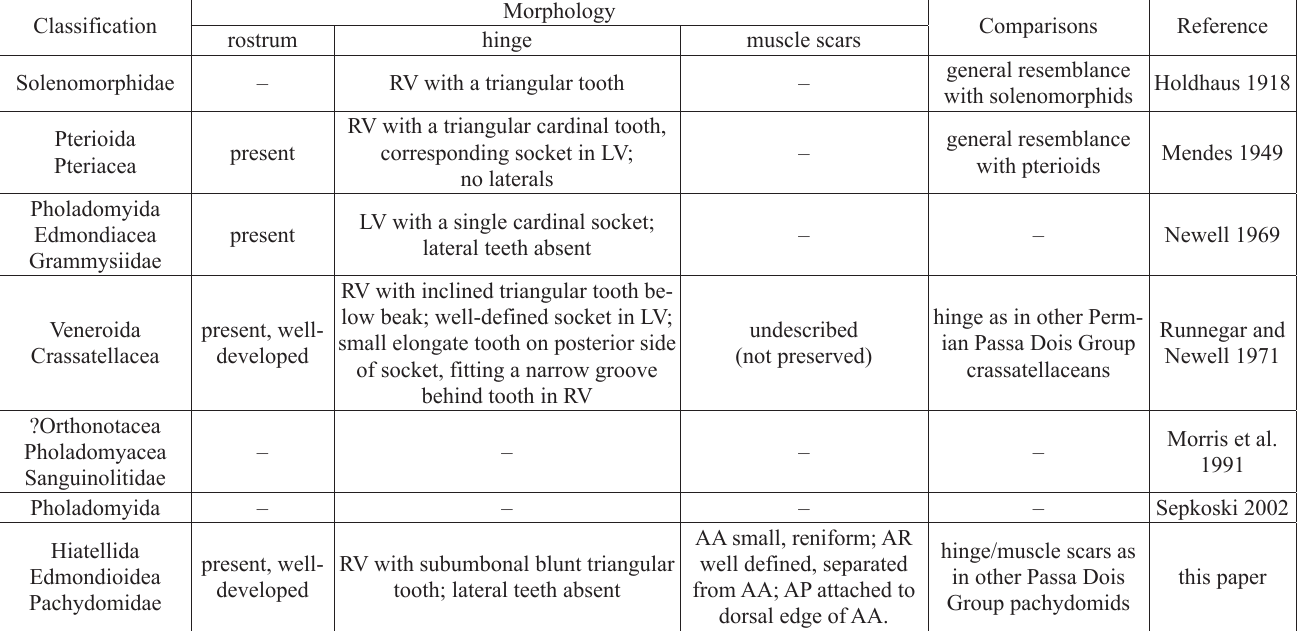
Table 1. Summary of Leinzia similis (Holdhaus, 1918) sensu stricto, classification and shell morphology according several authors. Abbreviations: AA, anterior adductor muscle scar; AR, anterior retractor muscle scar; AP, anterior protractor muscle scar; LV, left valve; RV, right